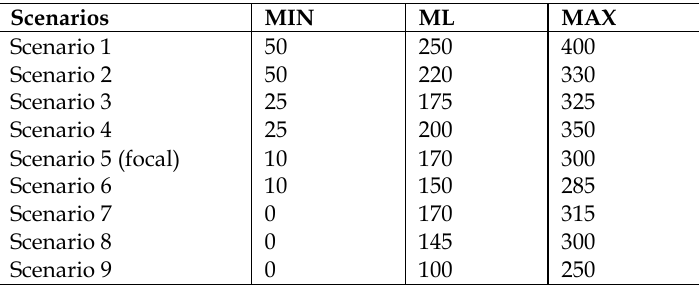
Table 5. Summary of the triple values applied for the RSF